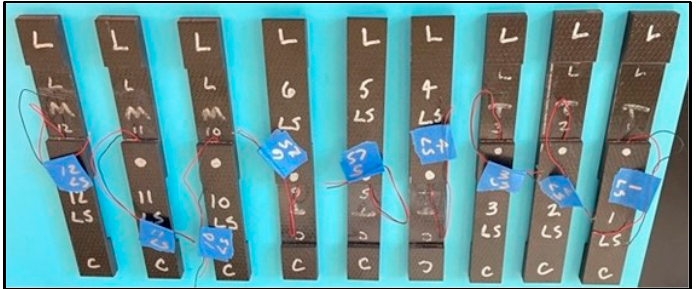
Figure 11. Embedded sensor lap shear test coupons.